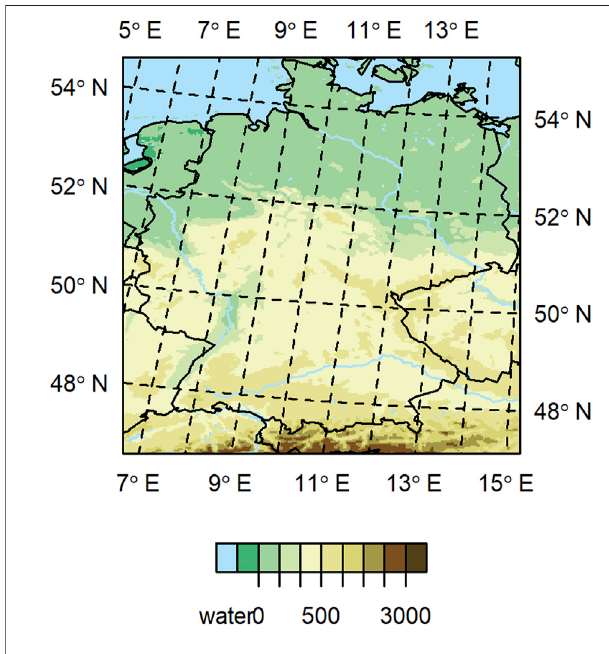
FIGURE1 | Geometric height in meters ofthe Earth ’ ssurface above sea level for the simulation domain.